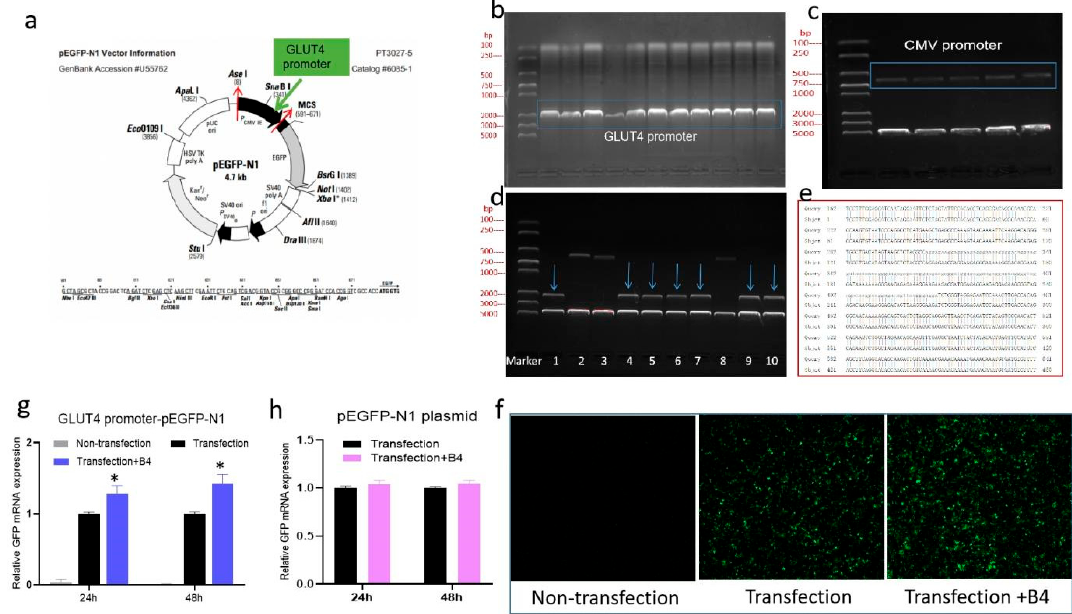
Figure 7. The effect of B4 on GLUT4 promoter plasmid. ( a ) The illustration of GLUT4 promoter replaced the CMV promoter of vector pEGFP-N1; ( b ) PCP amplification for GLUT4 promoter; ( c ) pEGFP-N1 for digestion; ( d ) Digestion of recombinant plasmids; ( e ) Gene sequencing and align- ment; ( f ) Fluorescent intensity of GLUT4 promoter plasmid after B4 treatment for 48 h; ( g ) GFP mRNA expression of GLUT4 promoter plasmid; ( h ) GFP mRNA expression of pEGFP-N1 control plasmid after B4 treatment for 24 h and 48 h. * p < 0.05 vs. Transfection group.